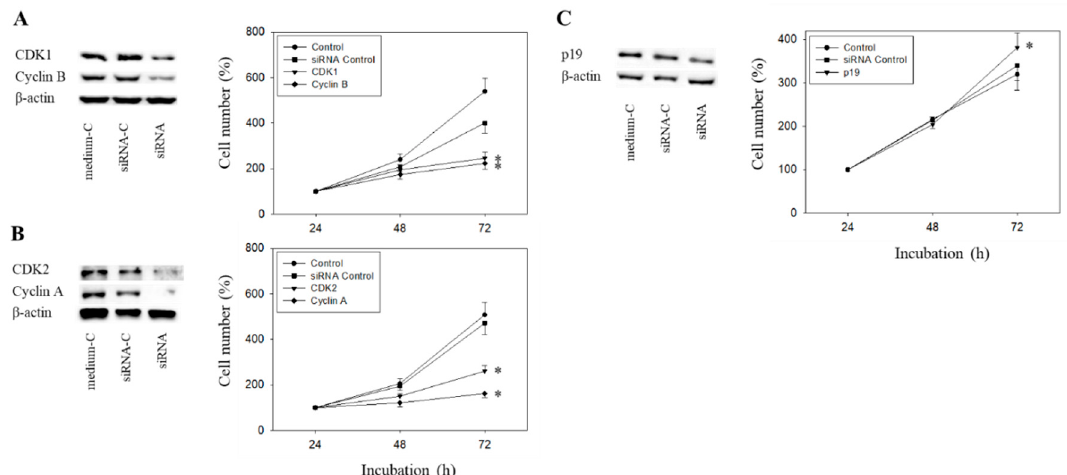
Figure 11. Tumor cell growth after functional blocking with small interfering RNA (siRNA) targeting CDK1 / cyclin B ( A ), CDK2 / Cyclin A ( B ), and p19 ( C ) of RT112 cells. Controls remained untreated. medium-C = cells treated with culture medium alone, siRNA-C = cells treated with unspecific siRNA, siRNA = cells treated with specific siRNA). β -actin served as the loading control. Protein data are shown on the left, growth response on the right side of the figure. One representative of three separate experiments is shown. ∗ indicates significant difference to control.